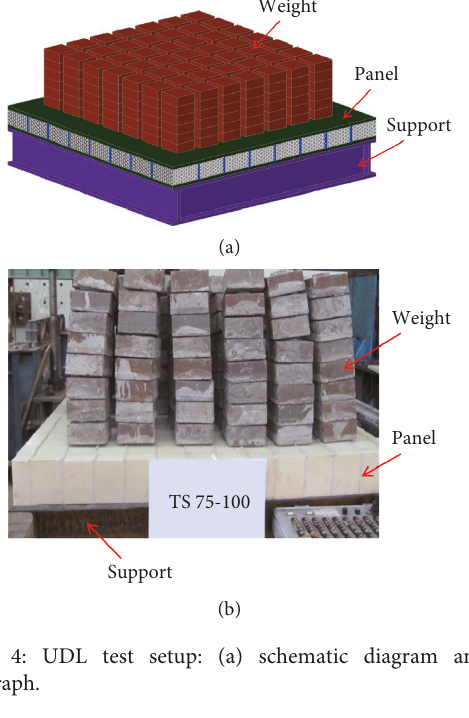
Figure 4: UDL test setup: (a) schematic diagram and (b) photograph.